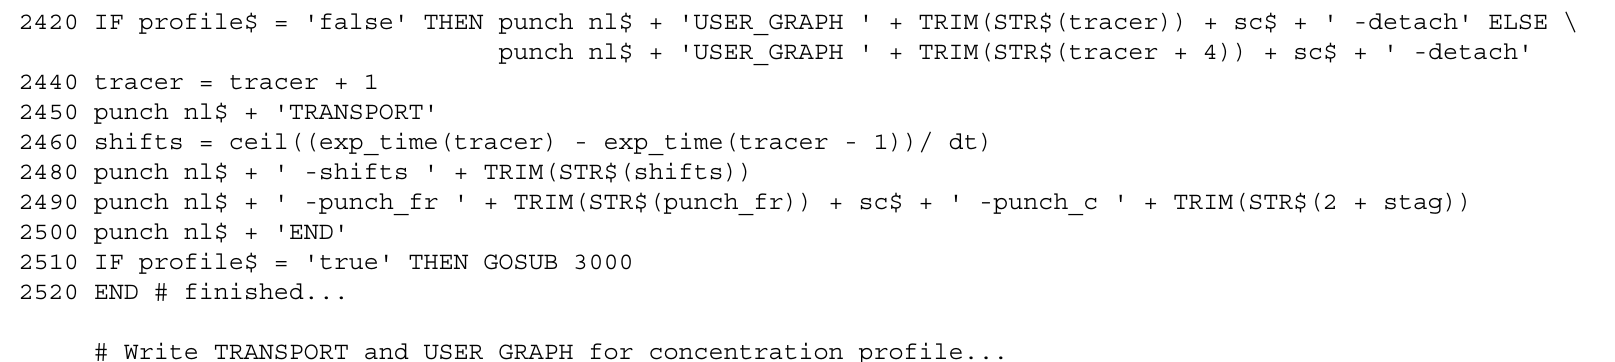
Table 60. Input file for example